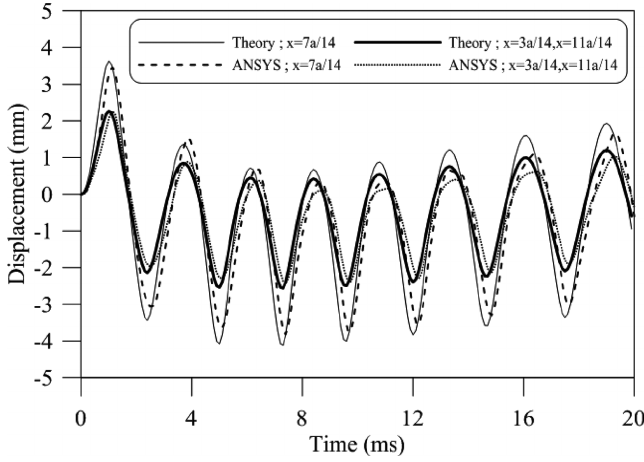
Fig. 4. The displacement-time histories of the simply-supported laminated fl at plates ( β = 0).